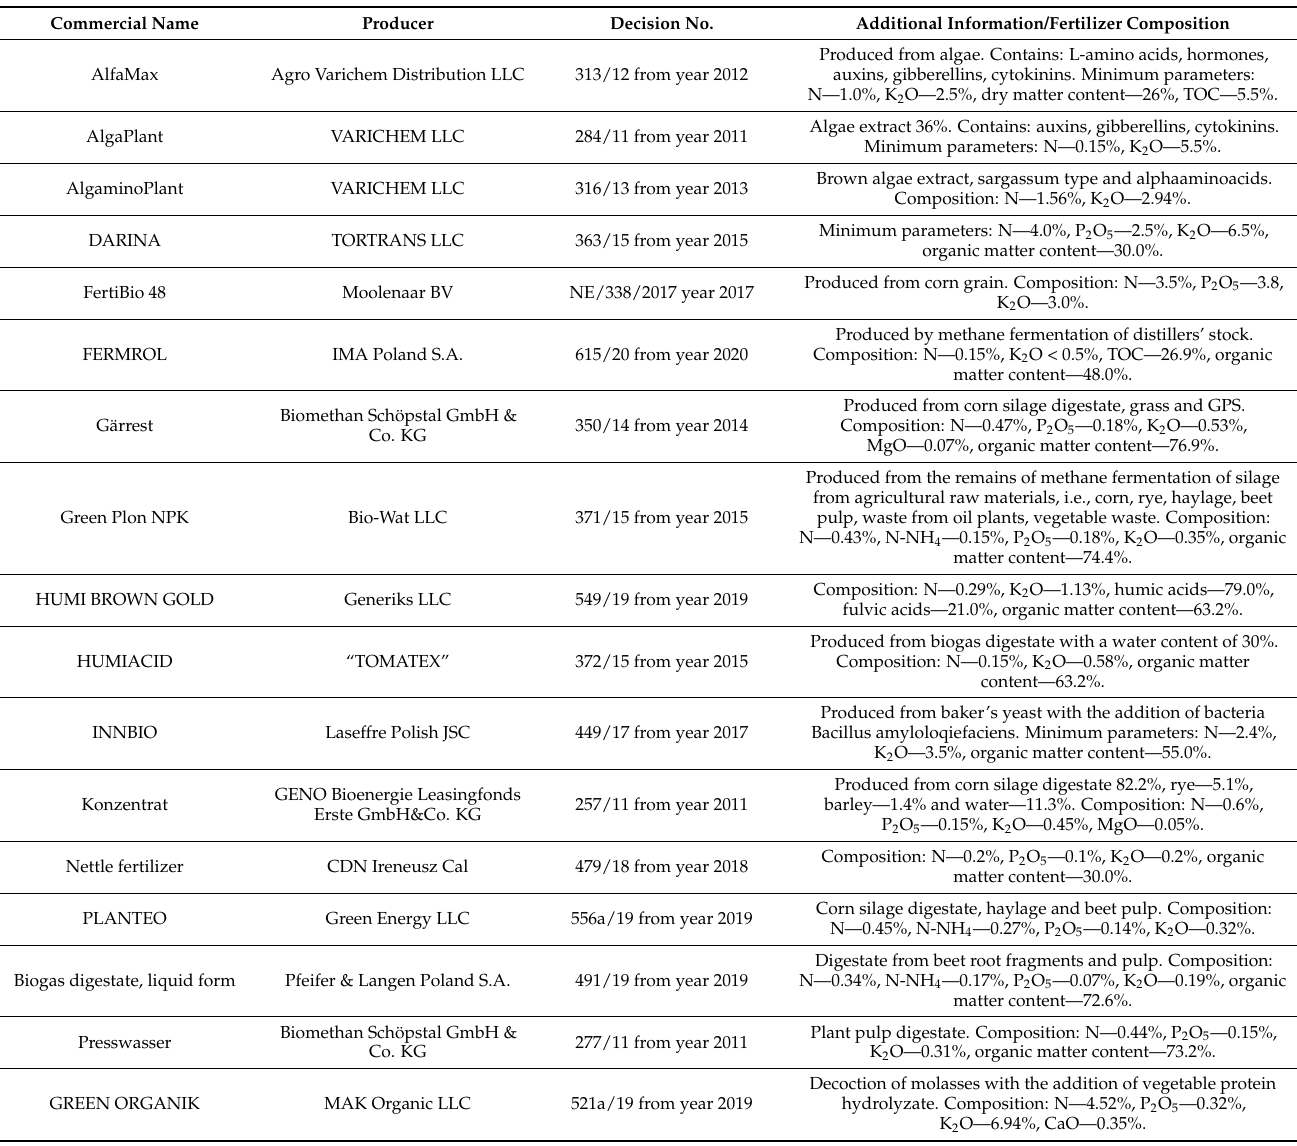
Table 7. Selected organic fertilizers in liquid form (authors’ own elaboration based on [74]).